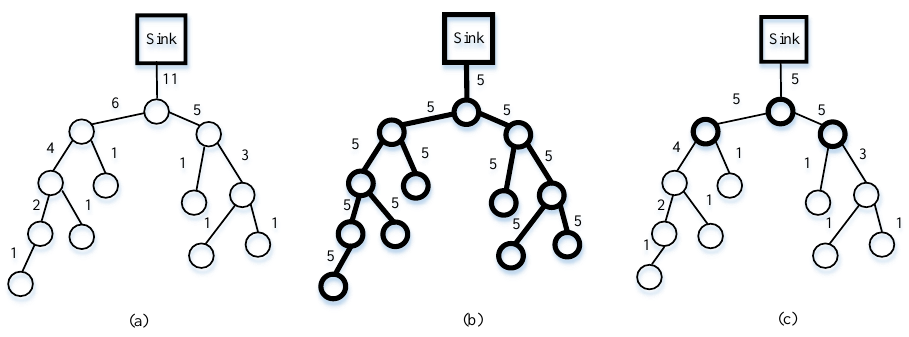
Figure 7. ( a - c ) Comparison of the three different data-gathering schemes.